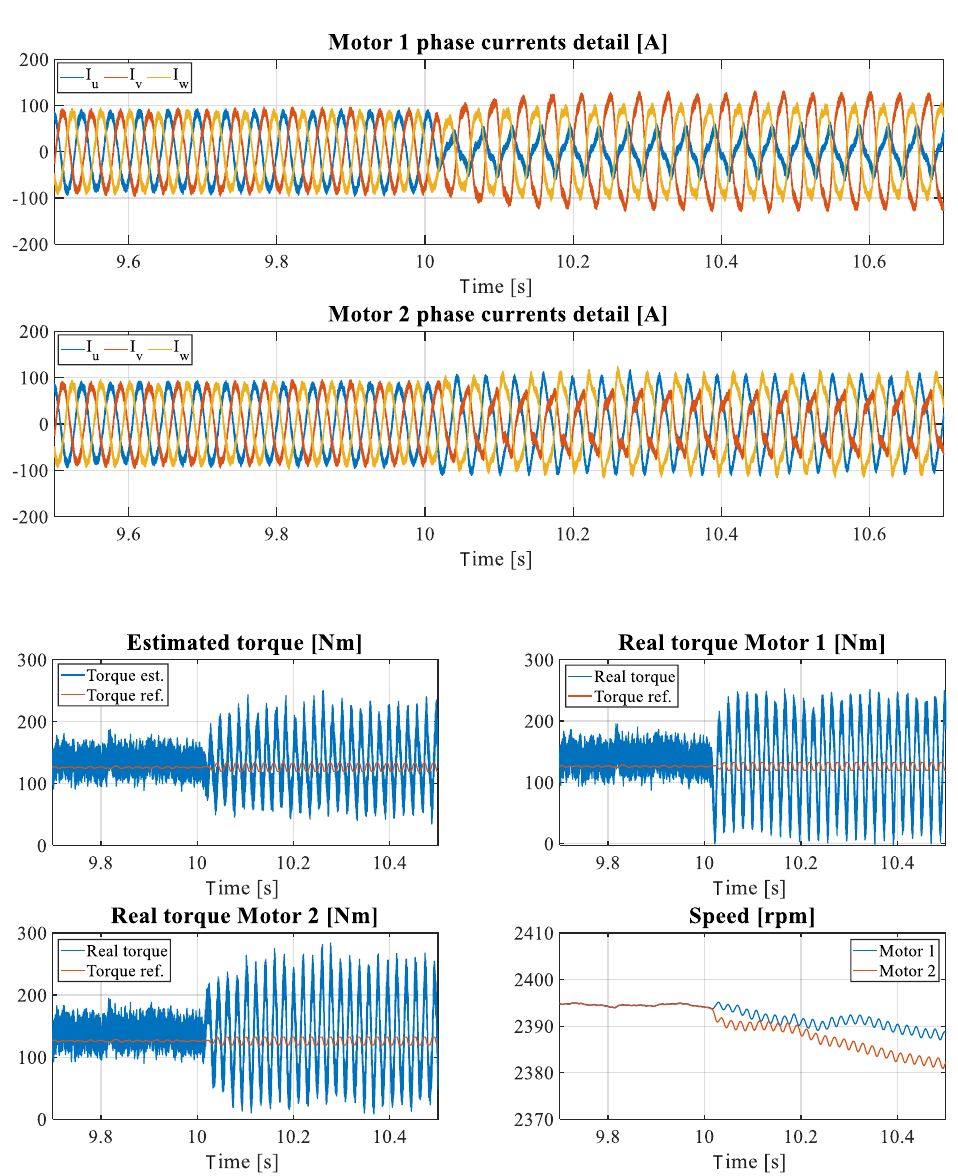
Figure 7. Phase currents of motor 1 and motor 2 at 2400 rpm and 100 Nm load (HRC/unbalanced fault at t = 10